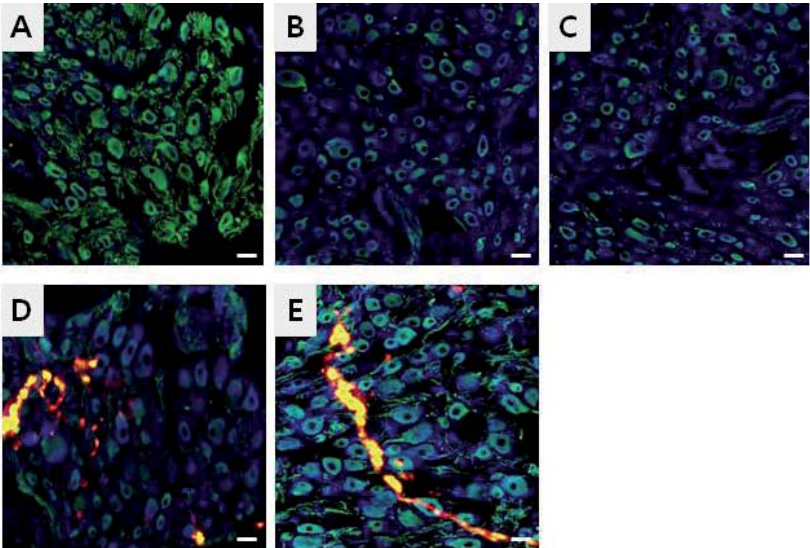
Figure 3 - The expression of mesenchymal derived stem cells (MSCs) in MPG at 4 weeks in control control (A); bilateral cavernous nerve (BCNC) crushing (B); BCNC with Matrixen (C); BCNC with mesenchymal stem cells (MSCs) (D); BCNC with MSCs mixed with Matrixen group (E). (x 400, blue:DAPI, green:tuj1, red: